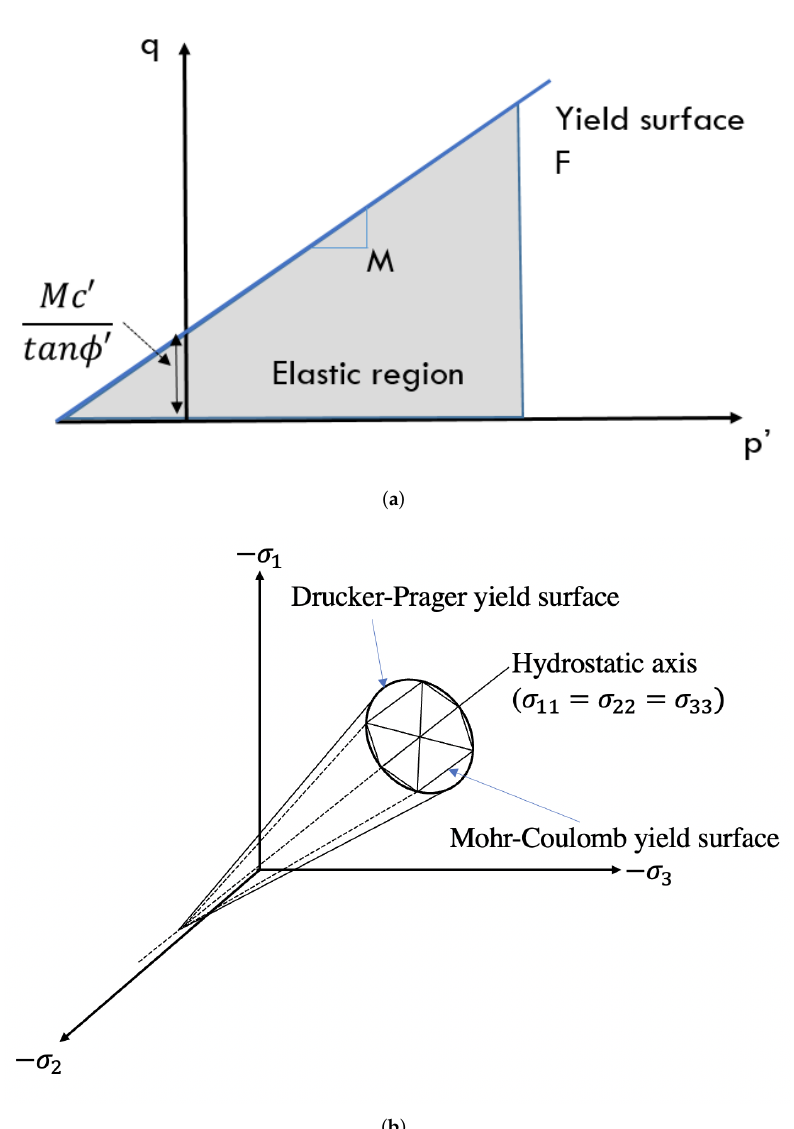
Figure 3. Yield surface for Drucker-Prager plasticity model in p’q space ( a ) and in principal stress space ( b